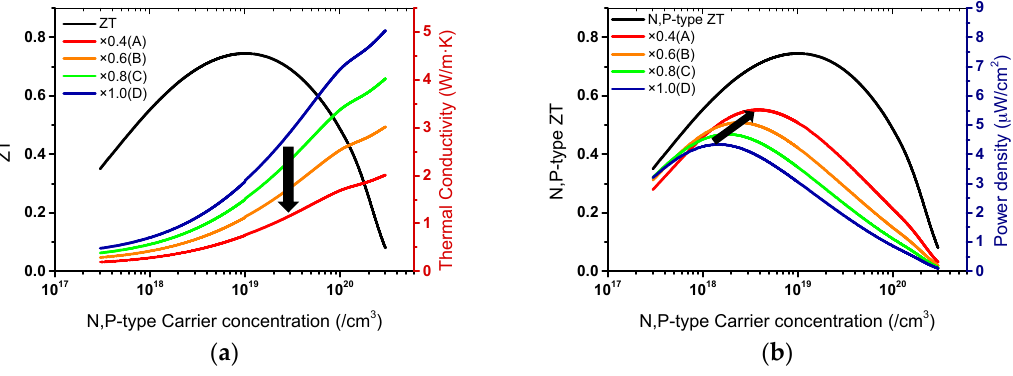
Figure 4. ( a ) The material data obtained by multiplying the electrical conductivity and the thermal conductivity of the P-type BiSbTe 3 data (D) by 0.4 (A), 0.6 (B), and 0.8 (C). ( b ) Device simulation using the thermoelectric material with different thermal conductivity but with the same ZT. From material D to material A, the thermal conductivity decreases and the maximum power density increases. The carrier concentration of the maximum power density shifts to the right as the thermal conductivity decreases.